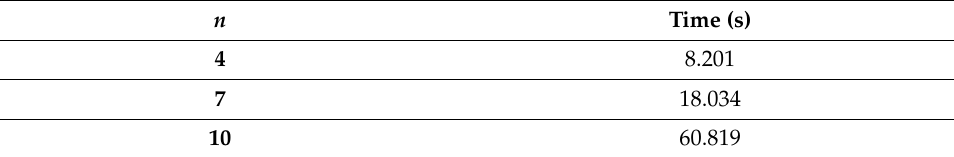
Table 4. CPU time taken in computation for different values of n at β = 0.9554170509, α = 1, µ = 1 and ρ =